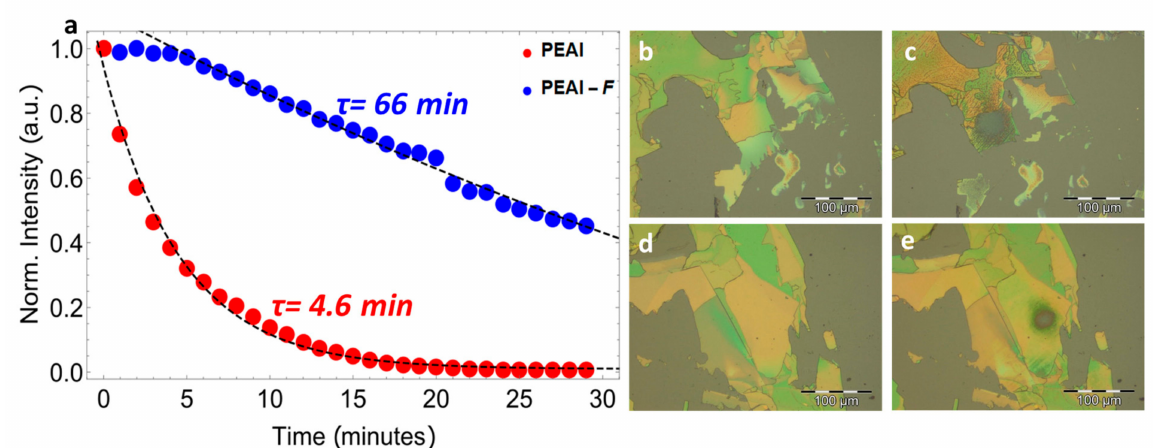
Figure 2. ( a ) Comparison of normalized counts for PEAI (red dots) and PEAI-F (blue dots) as a function of time. Optical image of PEAI single crystal before; ( b ) and after; ( c ) laser irradiation. Optical image of PEAI-F single crystal before; ( d ) and after ( e ) laser